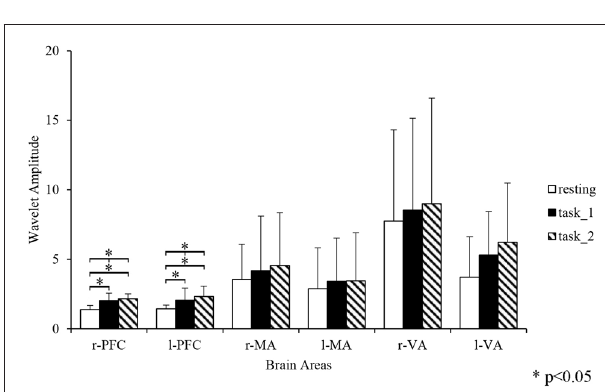
FIGURE 5 | Comparison of the WA in the six brain areas among the three states. “ ∗ ” Indicates a statistically significant change. Abbreviations: r-PFC, right prefrontal cortex; l-PFC, left prefrontal cortex; r-MA, right motor-related areas; l-MA, right motor-related areas; r-VA, right vision-related areas; l-VA, left vision-related areas; WA, wavelet